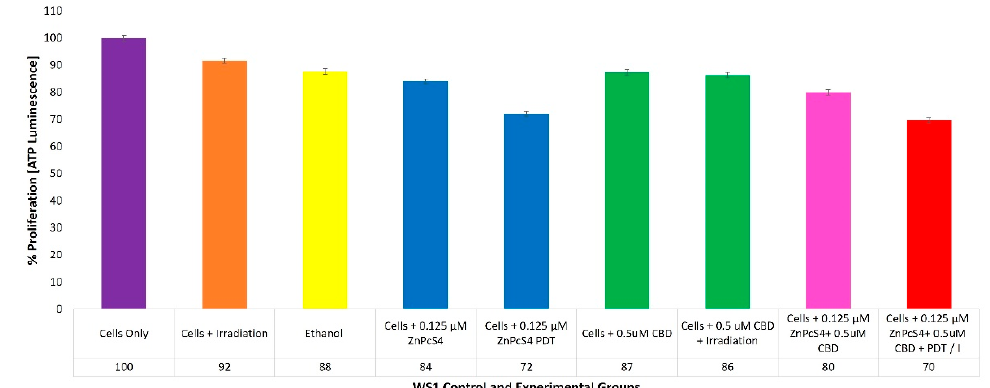
Figure 8. Percentage of cell proliferation of various WS1 normal fibroblast control and experimental groups, within ZnPcS 4 PS and CBD post-irradiation combinative assays.